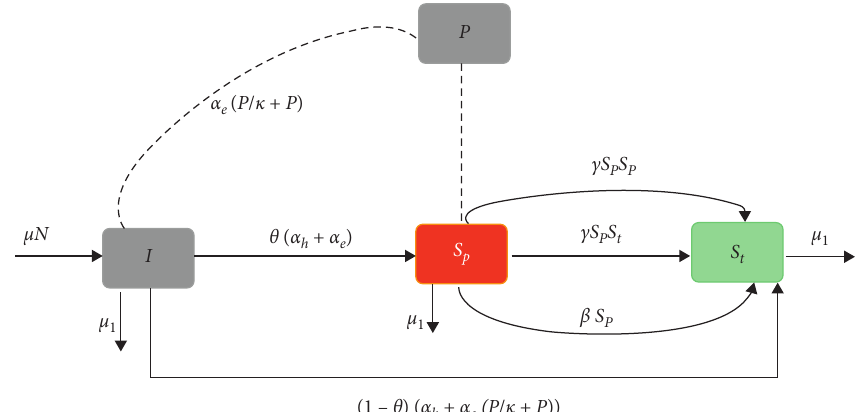
Figure 1: Description diagram of the rumor dynamics.